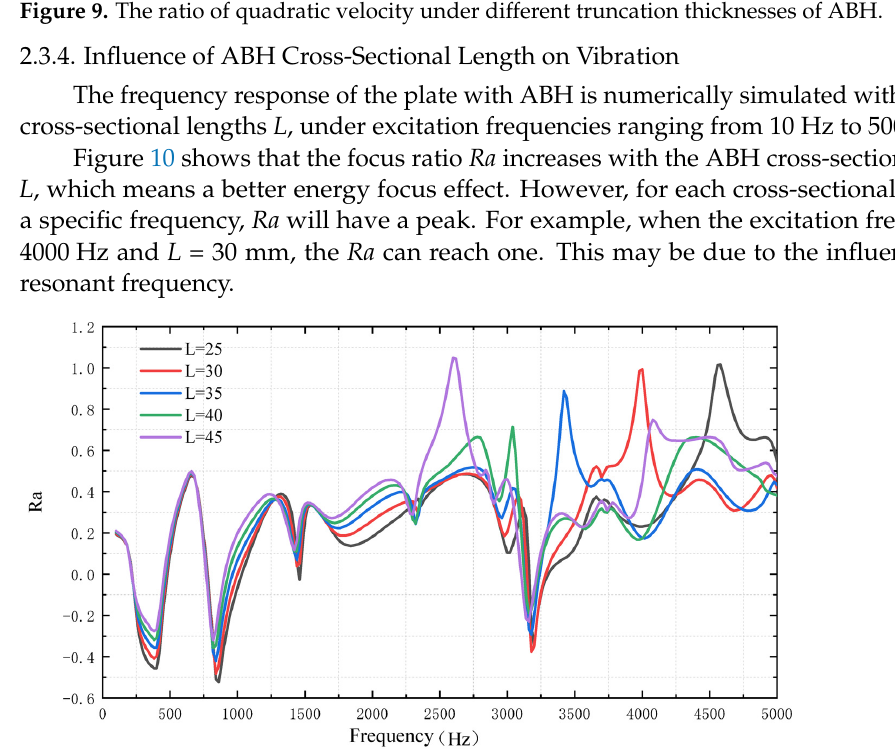
Figure 10. The ratio of quadratic velocity under different cross-sectional lengths of ABH.